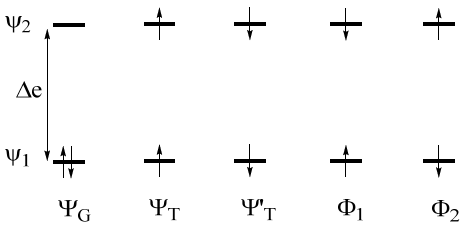
Figure 18. Five configurations leading to the ground and excited singlet states, as well as the excited triplet state. It is assumed that the energy difference ∆ e between the two MOs ψ 1 and ψ 2 is large, so the ground singlet state is well approximated by Ψ G . Molecules 2020 , 25 , x